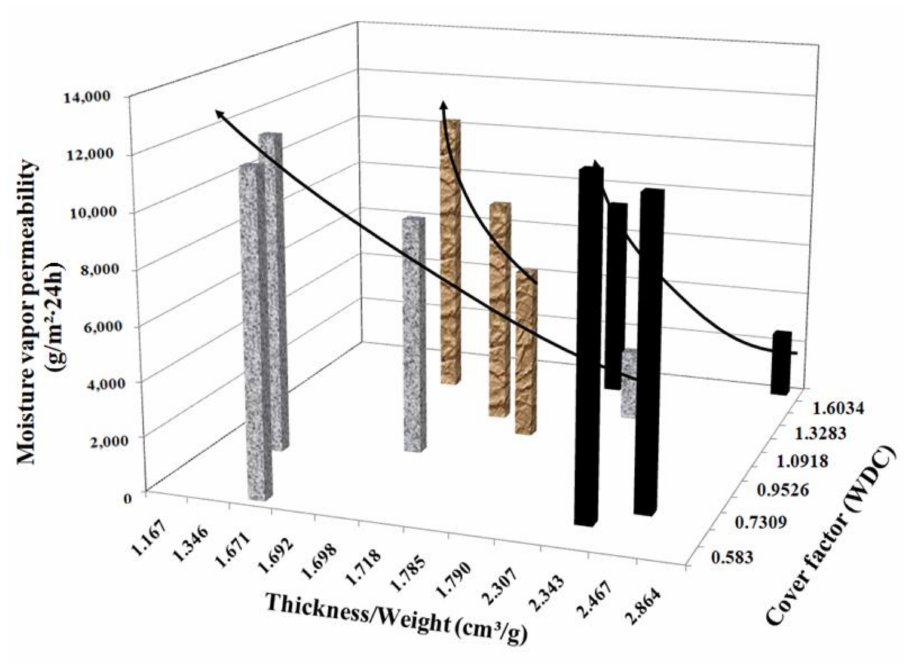
Figure 4. WVP against fabric structural